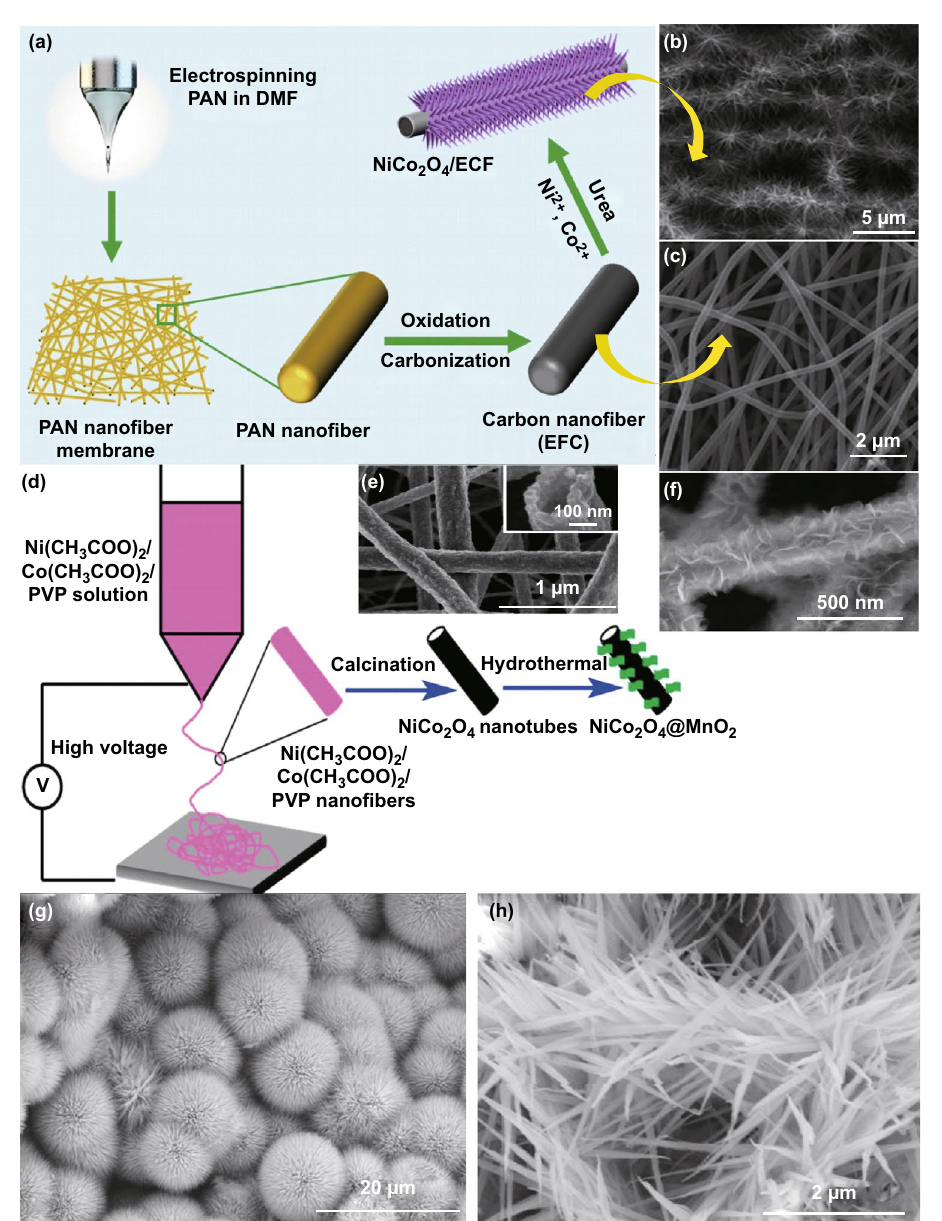
Fig. 18 a Fabrication procedure of NiCo 2 O 4 /ECF nanohybrids, b FESEM image of ECF and c FESEM image of NiCo 2 O 4 nanoneedles grown on ECF. Reproduced with permission from Ref. [39]. Copyright © 2017 Elsevier B.V. d The fabrication procedure for NiCo 2 O 4 @MnO 2 com- posites, e FESEM image of NiCo 2 O 4 nanotubes and f FESEM image of MnO 2 nanosheets grown of NiCo 2 O 4 nanotubes. Reproduced with permission from Ref. [200]. Copyright © 2016 Elsevier B.V. g, h Low- and high-magnification FESEM images, respectively, of NiCo 2 O 4 with uniform dandelion-like morphologies. Reproduced with permission from Ref. [203]. Copyright © 2019 Elsevier